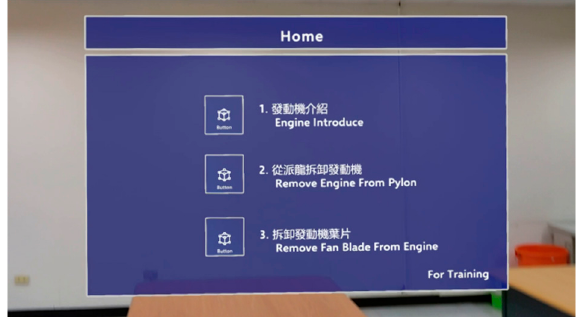
Figure 2. The initial screen of the engine maintenance mixed reality system.